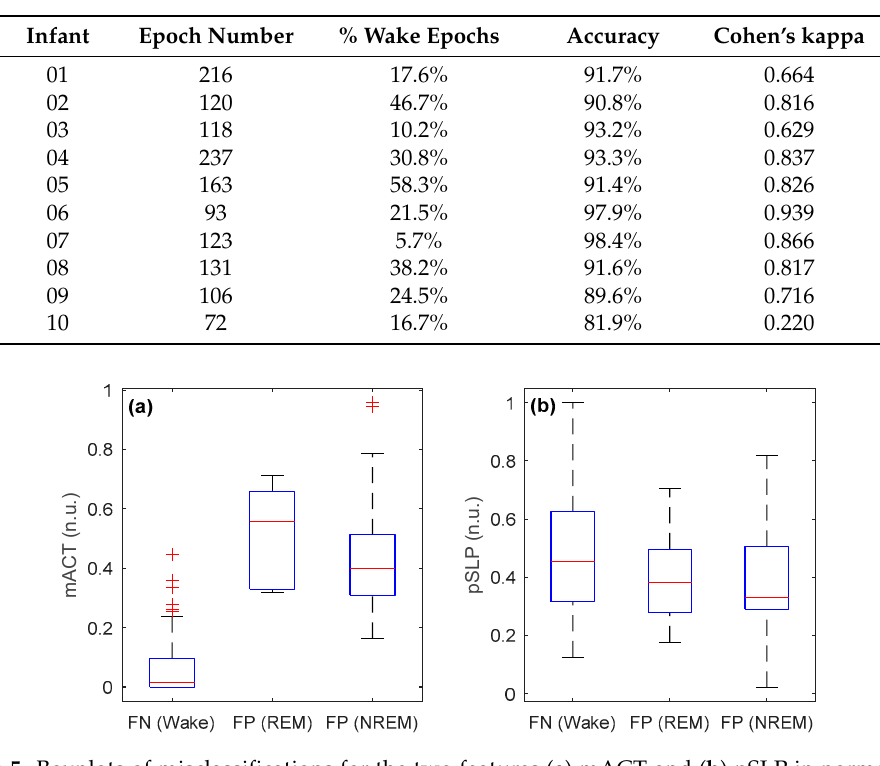
Figure 5. Boxplots of misclassifications for the two features ( a ) mACT and ( b ) pSLP in normalized unit (n.u.) where false negatives (FN) are the number of wake epochs misclassified as sleep epochs (FN = 71) and false positives (FP) are the number of sleep epochs incorrectly classified as wake epochs (FP = 7 for rapid eye movement (REM) sleep, FP = 28 for non-REM (NREM) sleep).